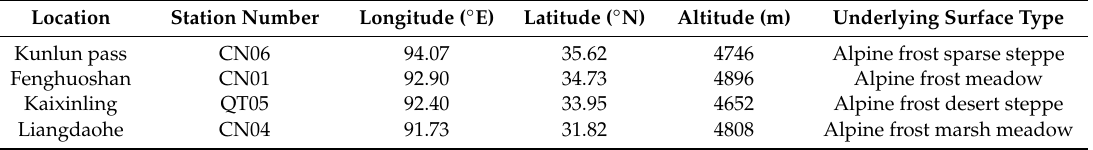
Table 1. The geographic information of the active layer observation sites.